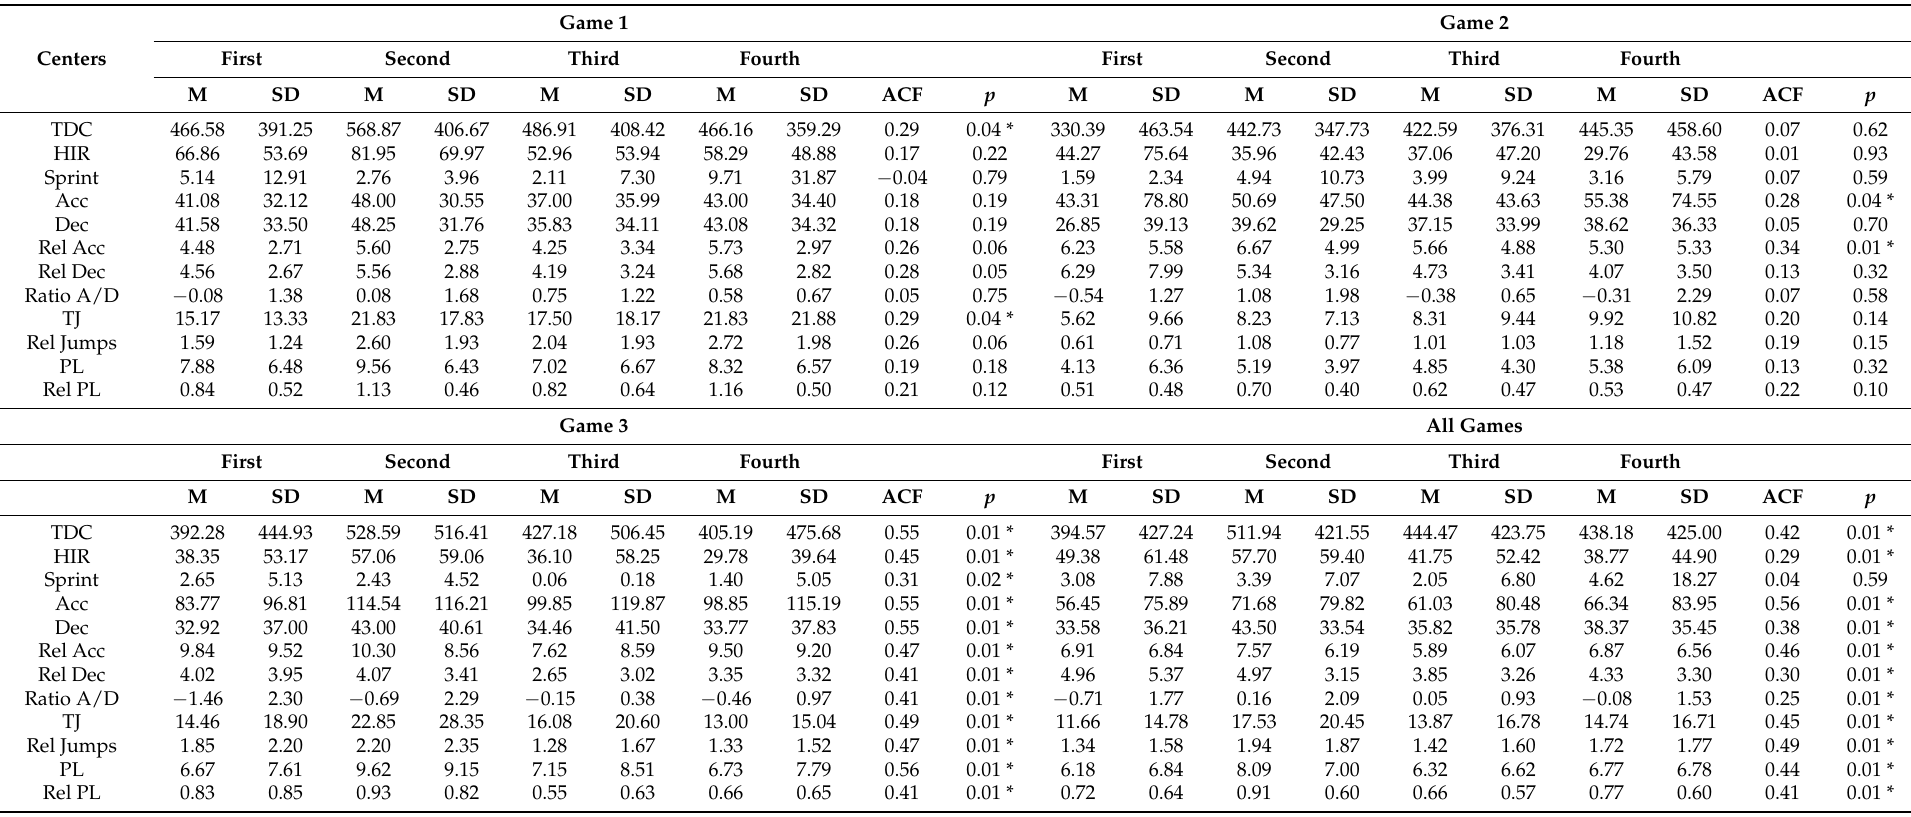
Table 4. Descriptive statistics for physical demands during games and quarters for center players (persistency of performances via ACF and p -values). Game Centers